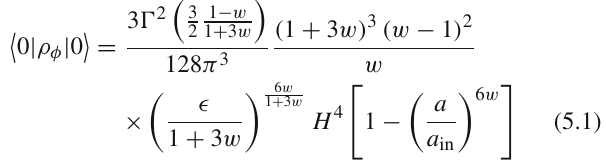
˙ φ 2 / 2 = π 2 /( 2 a 6 ) , see Eq. (3.1). One thus rise to 6 ρ φ = ¯ π, ¯ π ( 0 )/( 2 a 6 ) , where the two-point has to compute (cid:8) ρ φ (cid:7) = (cid:21) t , t functions (cid:5) t , t (cid:3) ( |(cid:9) x (cid:3) − (cid:9) x | ) are given in Eq. (3.15). Making use of Eq. (4.3) for the noise correlator and of Eq. (4.4) for